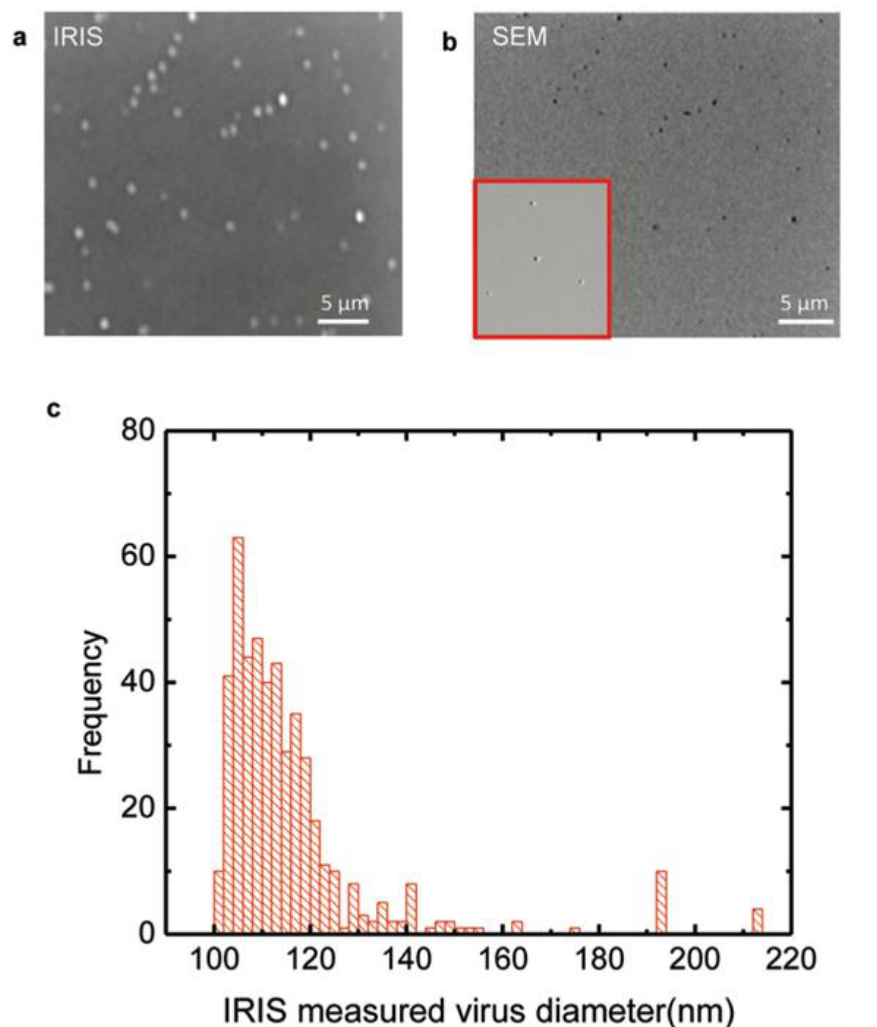
Figure 1. Imaging and sizing of H1N1 influenza virus. ( a ) IRIS image of captured viruses on the chip surface; ( b ) SEM photo of the same area monitored with IRIS; ( c ) size distribution of viruses measured by IRIS [20]. Reproduced with permission from G.G. Daaboul, A. Yurt, X. Zhang, G.M.